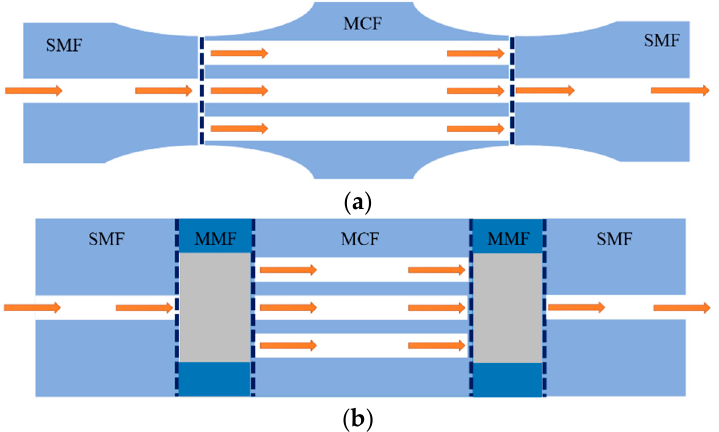
Figure 13. Schematics of the typical coupling methods of the MCF-based Mach–Zehnder interferometer. ( a ) Tapering the MCF at the fusing point, ( b ) fusing a segment of MMF between the SMF and MCF.